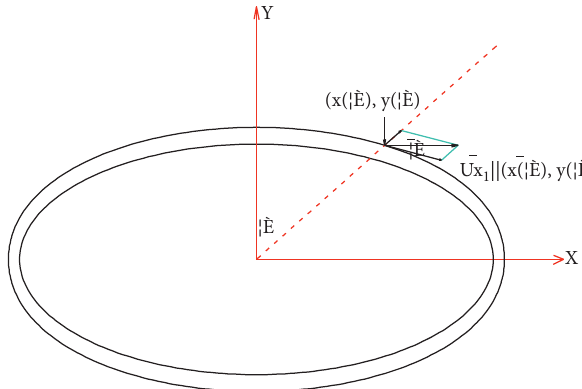
Figure 4: Figure ellip[[parms resize(1),pos(50,50),si- ze(200,200),bgcol(156)]]ical cylindrical